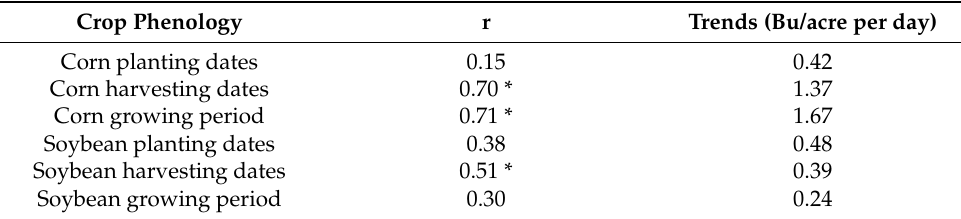
Table 6. Correlations between crop phenology and crop yields in Kentucky, 2000–2018. Crop Phenology r Trends (Bu/acre per day) Corn planting